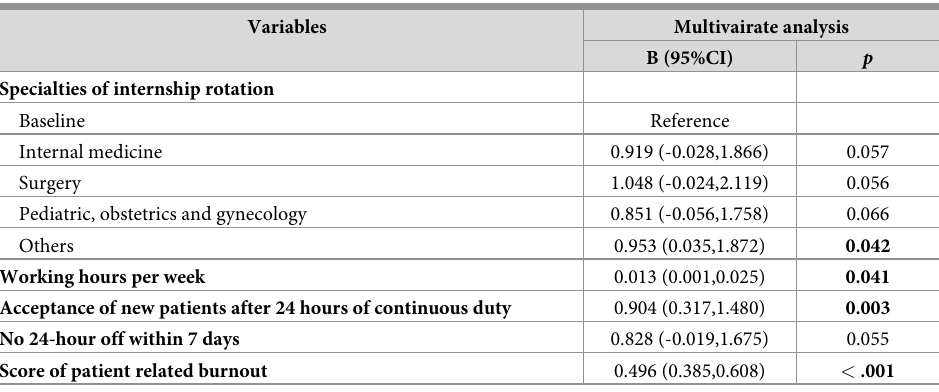
Table 2. Effectors of self-rating depression